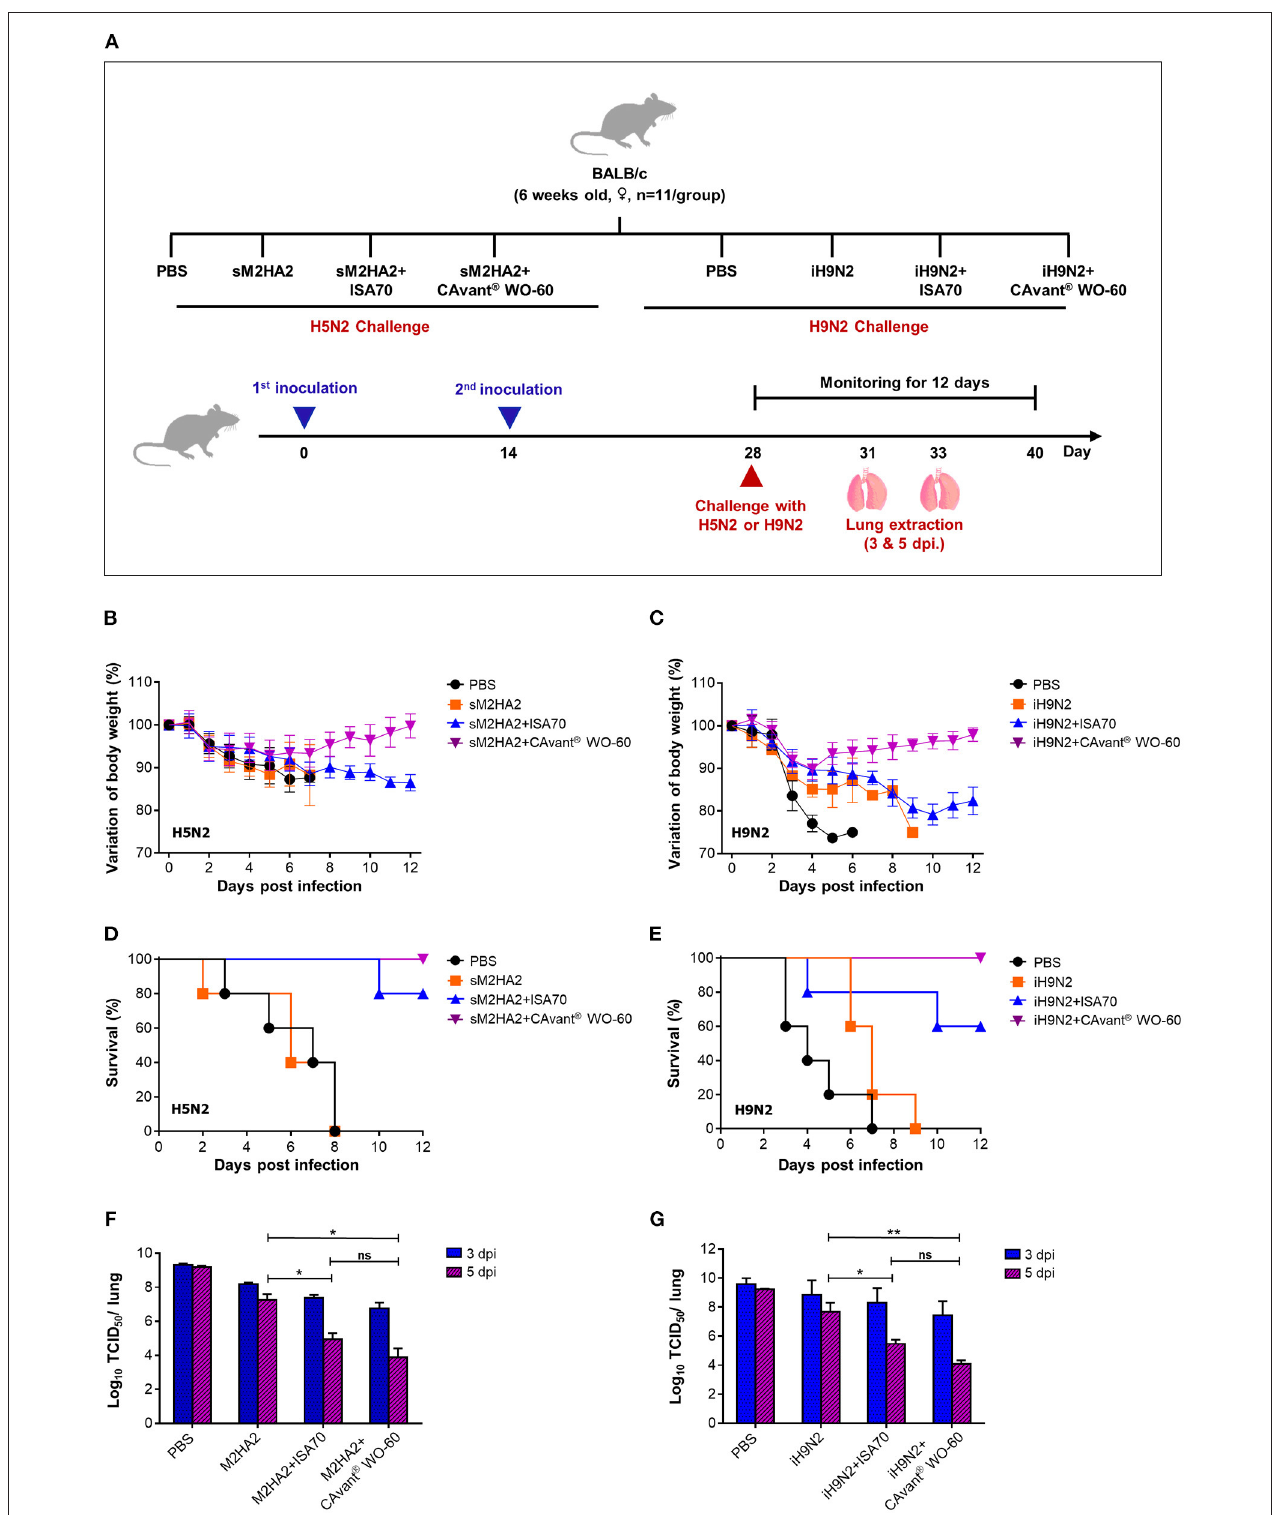
FIGURE 3 | Protective efficacy against lethal influenza virus infection in mice. (A) Schematic depiction of mice experiment strategy. BALB/c mice were intramuscularly administrated twice every other week. Mice were intranasally challenged with 10LD50 of mouse-adapted A/Aquatic bird/Korea/W81/2005(H5N2) and A/Chicken/ Korea/01310/2001(H9N2) at 2 weeks after the second immunization. (B,C) The changes in body weight and (D,E) survival rate after performing lethal challenges